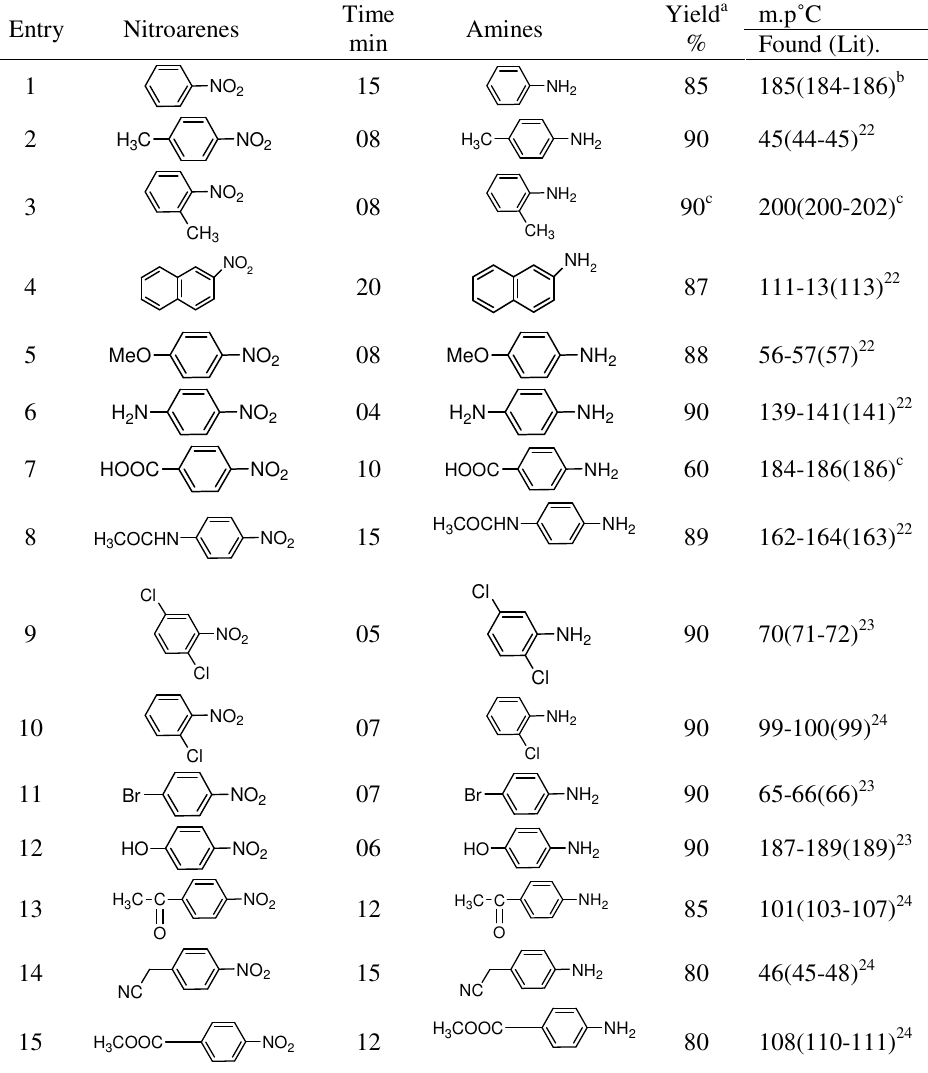
Table1 . Reduction of nitroarenes to anilines with diammonium hydrogen phosphite and commercial zinc dust in